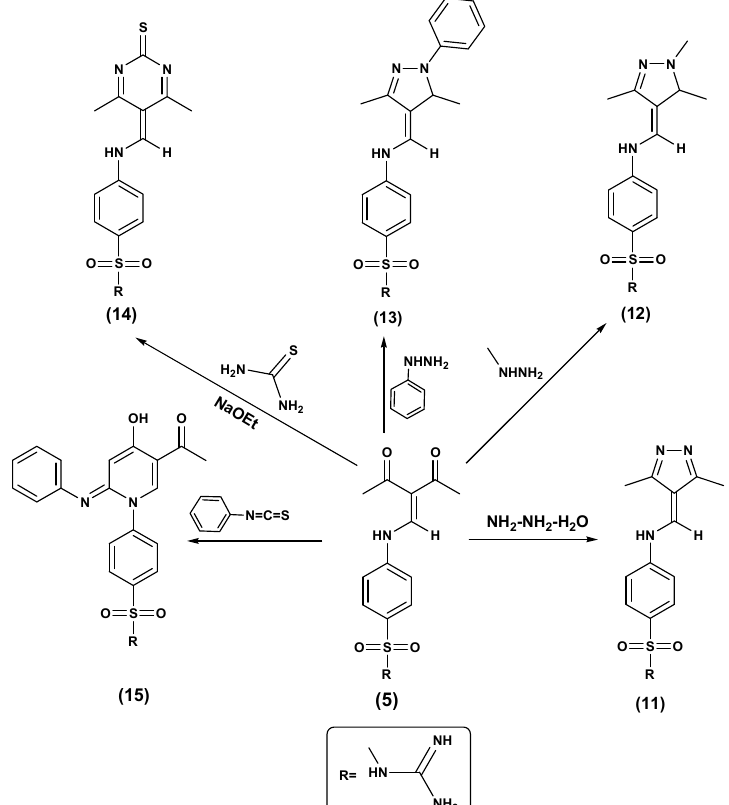
Scheme 3. Synthetic pathways for compounds 11 – 15